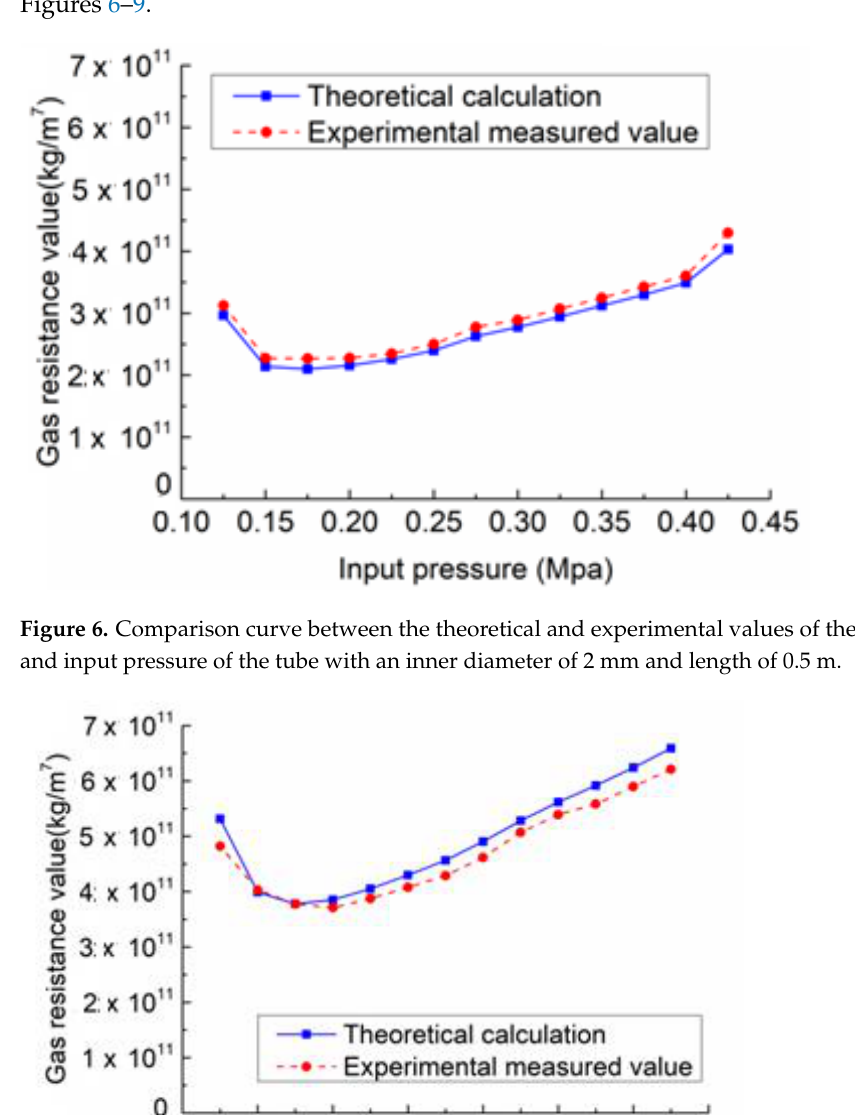
Figure 8. Comparison curve between the theoretical and experimental values of the gas resistance and input pressure of the tube with an inner diameter of 4 mm and tube of 0.5 m. Figure 9. Comparison curve between the theoretical and experimental values of the gas resistance and input pressure of the tube with an inner diameter of 4 mm and length of 1.0 m. Accordingly, the following observations are obtained from the figures: 1. An inflection point exists in the theoretical and experimental air resistance values in Figures 6–9, and the change trend of the air resistance value 𝑅 𝑔 varies from gradually